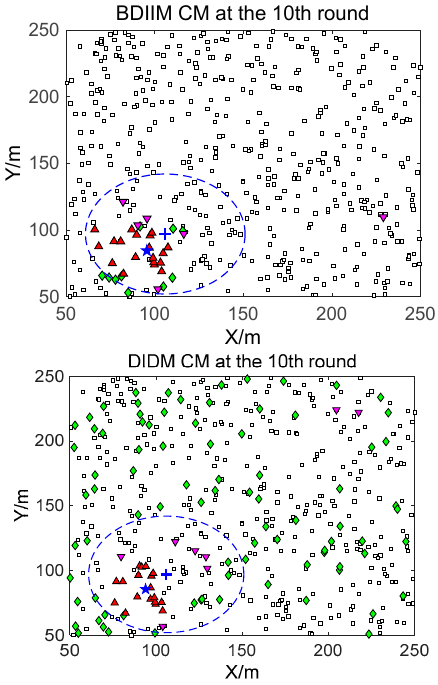
Figure 8. The state of the communication module (CM) at the 10th time interval.